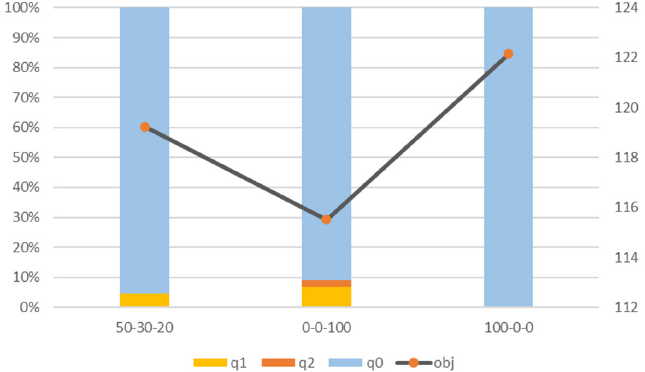
Figure 9. Impact of different distribution policies on the routing costs.